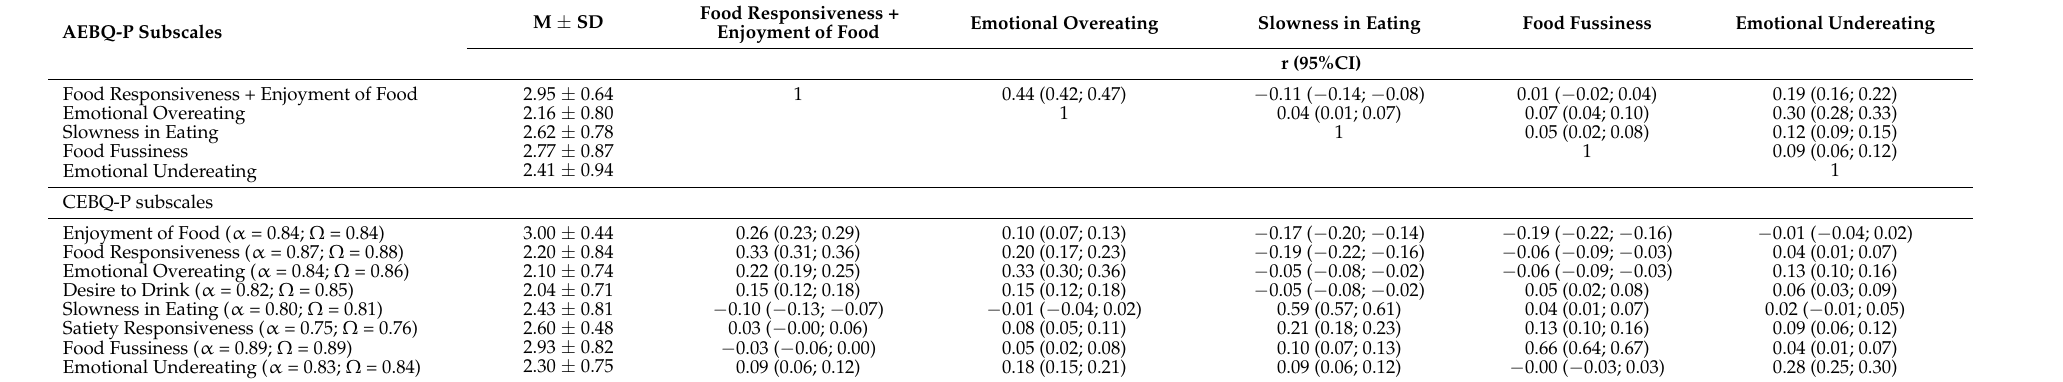
Table 4. Descriptives and Pearson’s correlations between the five proposed AEBQ-P subscales and the eight parent-reported CEBQ subscales. ± SD Food Responsiveness + Enjoyment of Food Emotional Overeating Slowness in Eating Food Fussiness Emotional AEBQ-P Subscales M